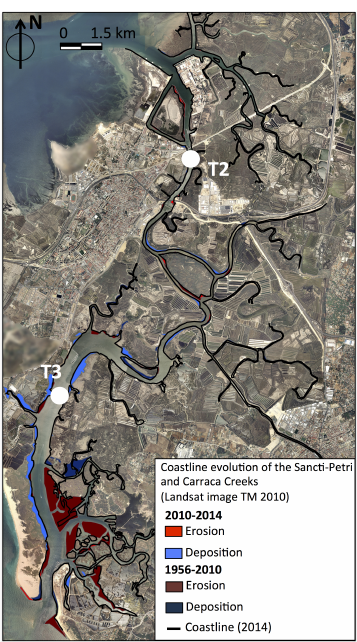
Figure 2. Morphological changes that have affected the CC and SPC networks from 1956 to 2014. Portions in which landscape erosion and deposition have been observed are in different colors. T2 and T3 refer to tidal